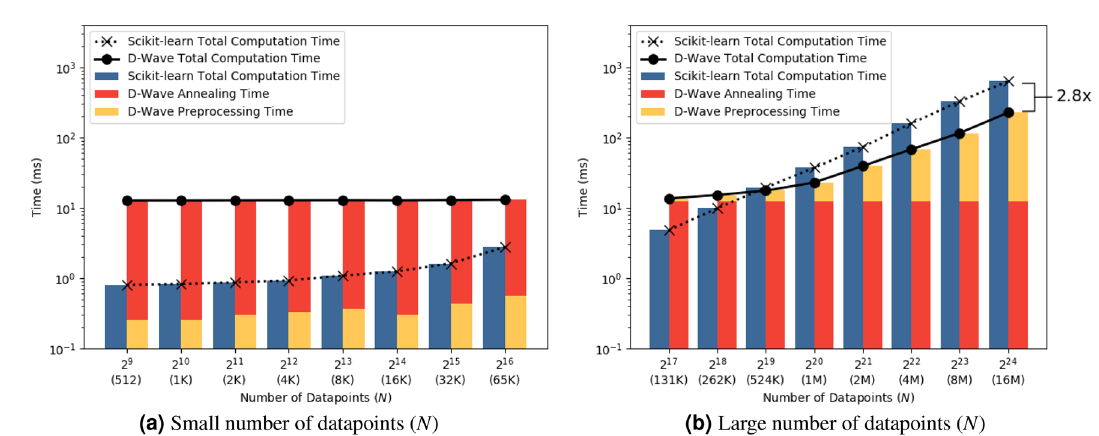
Figure 3. Scalability comparison of Scikit-learn regression (blue bars and dotted line) and D-Wave regression (yellow and red bars, and bold line). X-axis shows number of datapoints in the training set ( N ), ranging from 2 9 (512) to 2 24 (16 million) across both figures. Y-axis shows run time milliseconds on a logarithmic scale. In Fig. 3a, N varies from 512 to 65, 536. In Fig. 3b, N varies from 131, 072 to 16, 777, 216. We observe a 2.8 speedup using D-Wave on the 16 million case in Fig.